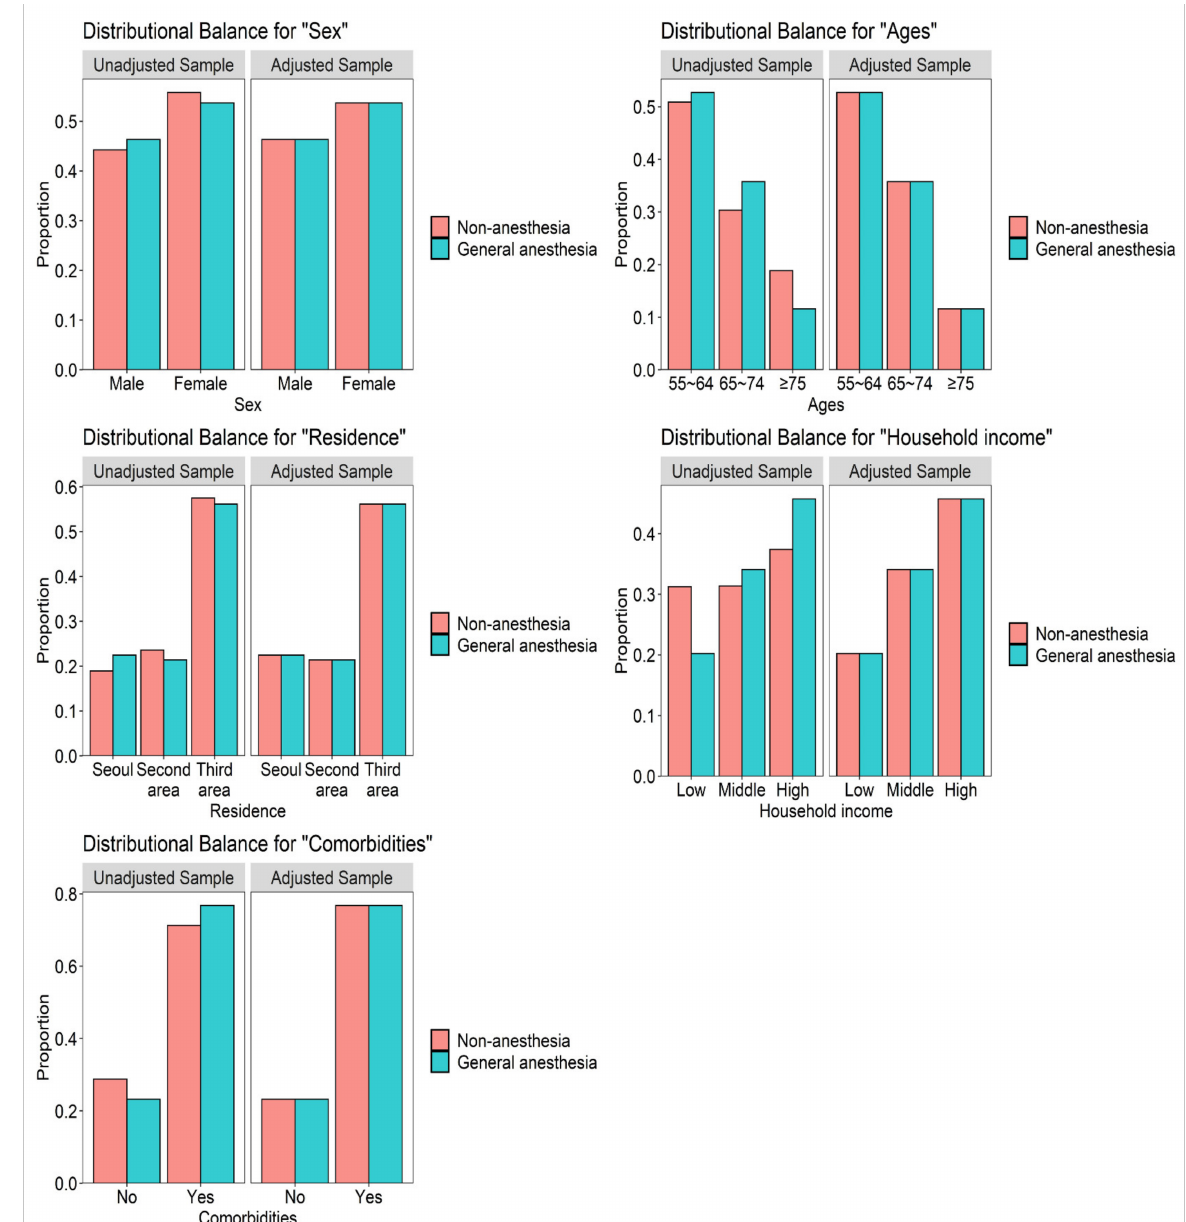
Figure 2. Balance plots of the five variables before and after